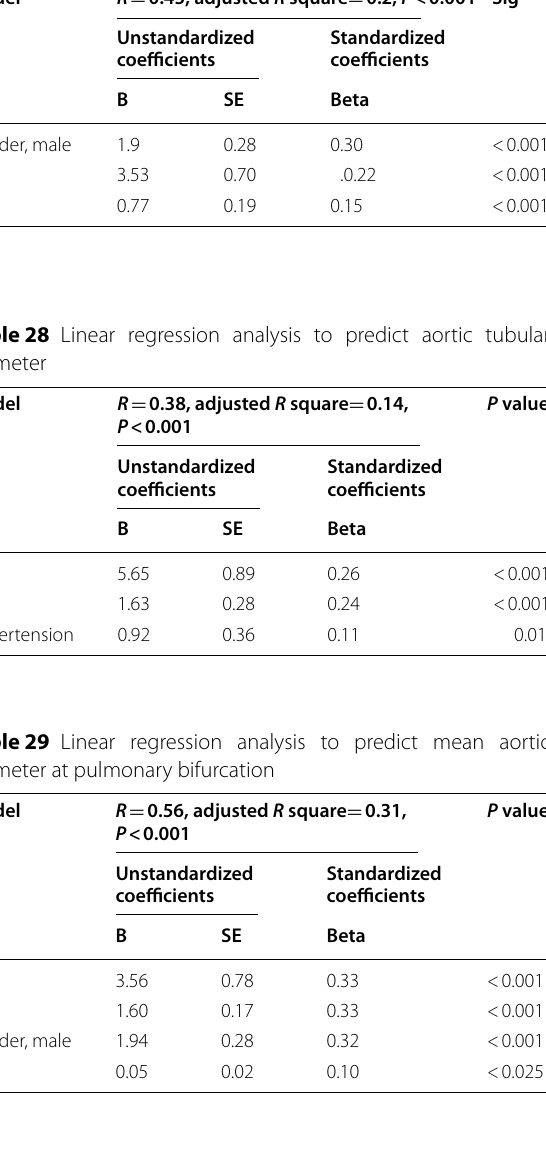
Table 27 Linear regression analysis to predict aortic STJ diameter Model